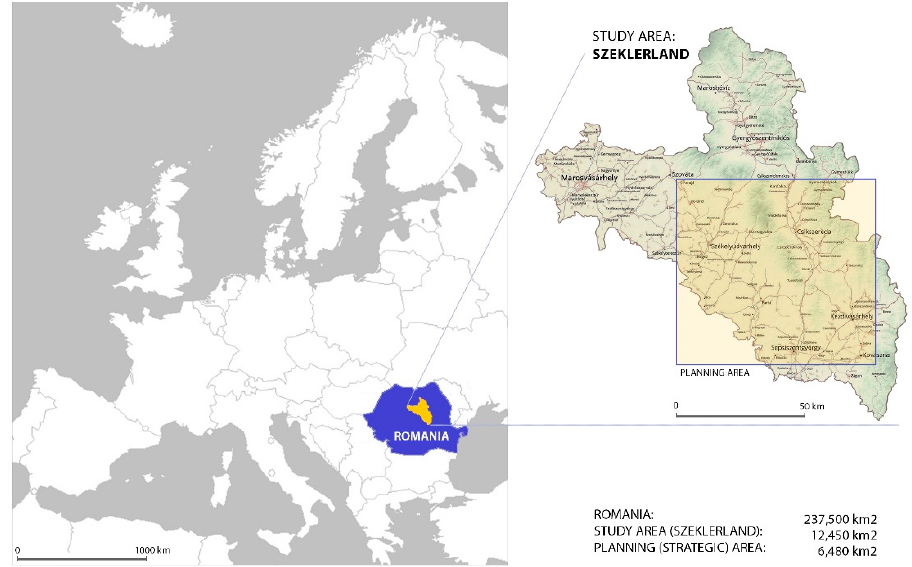
Figure 1. Location of the study area (Szeklerland) and planning (strategic) area on the map of Europe. Source: prepared by the authors based on the map of Szeklerland